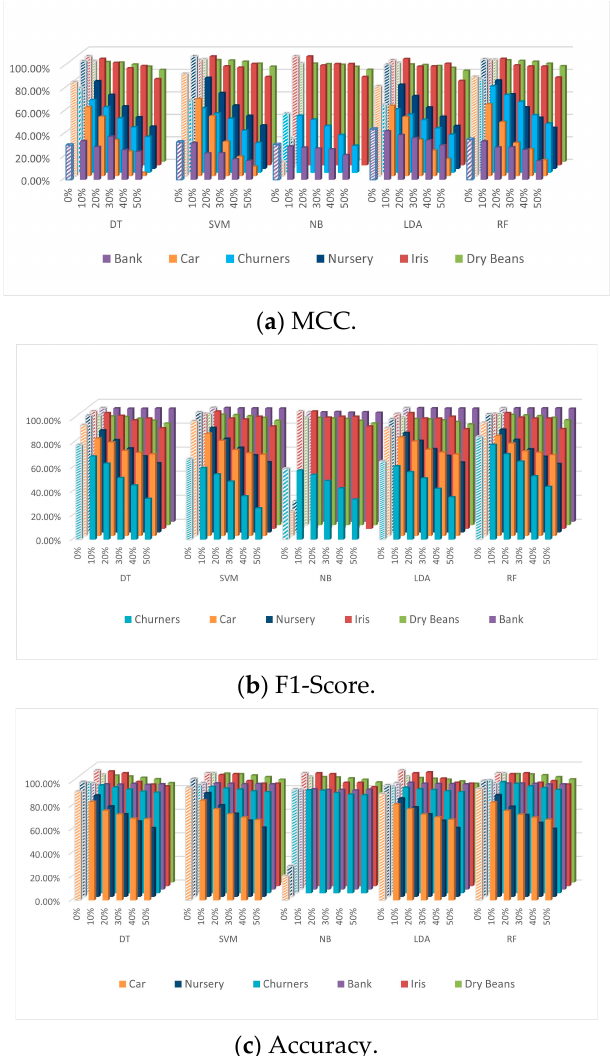
Figure 2. Performance of the five classifiers on the six datasets with different ratios of MCAR MVs imputed using KNN.